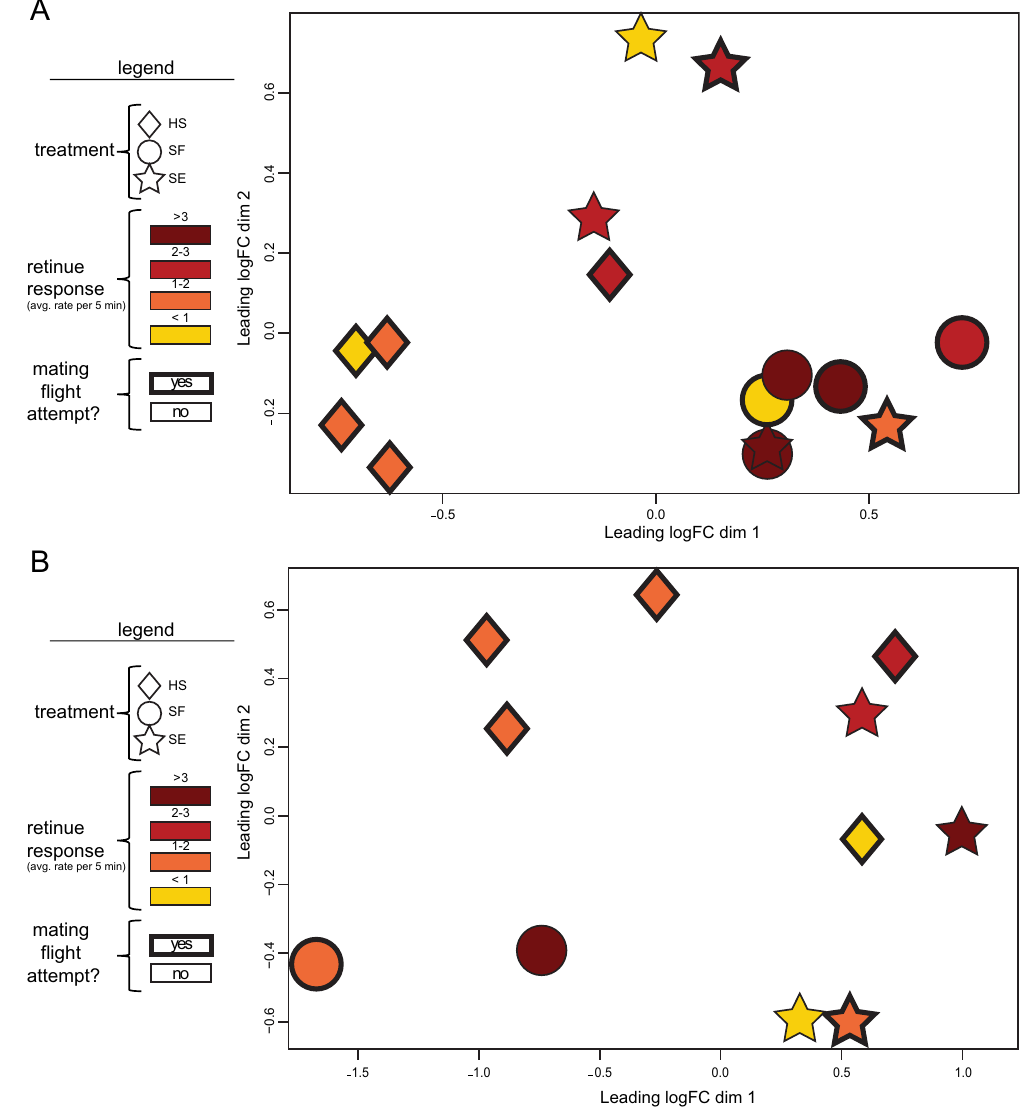
Figure 4. Multidimensional Scaling (MDS) plot of the top 500 expressed genes of ( A ) fat body samples and ( B ) brain samples generated with Limma in R. Distances between samples are approximations of typical (root- mean-square) log2-fold-change between the samples. Samples that are clustered closer to each other have less dissimilar expression profiles than samples that are located farther apart. Different shapes represent the different treatments: queens injected with Hayes Solution (HS), seminal fluid-injected queens (SF), and semen-injected queens (SE). Colors represent the average number of workers attenuating each queen per five minutes. Shapes with thick outlines represent queens that attempted a mating flight. ( A ) The expression profiles of fat body samples tended to cluster by treatment, and fat body samples from queens that were injected by semen or seminal fluid tended to cluster together. ( B ) The expression profiles of brain samples appeared to cluster by treatment except that SE queens were dispersed along the